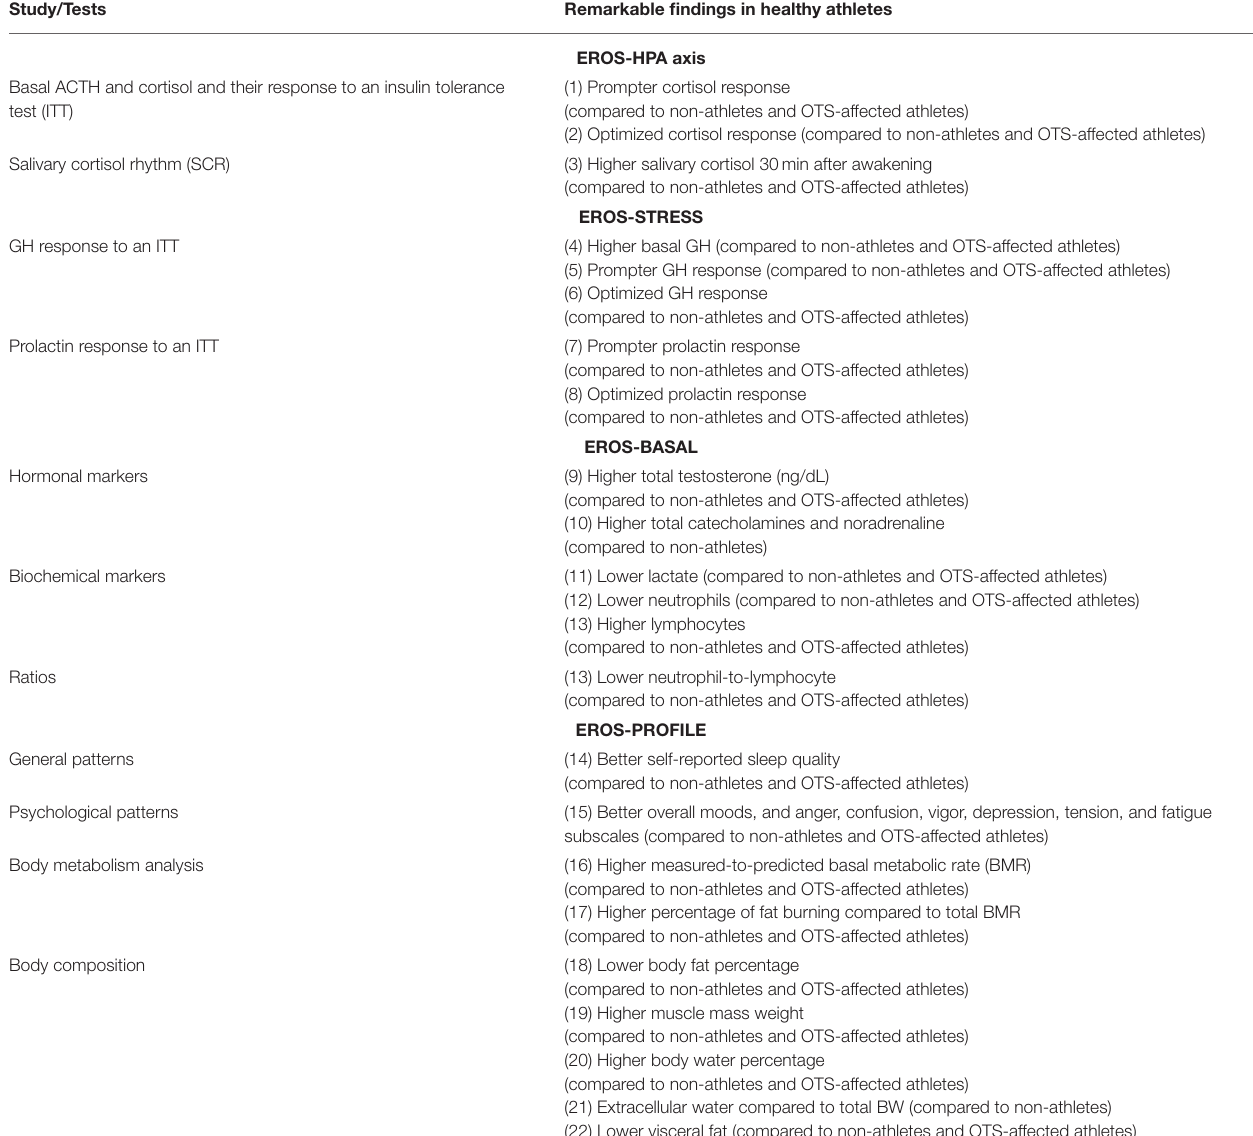
TABLE 6 | Most remarkable findings of the EROS study in healthy athletes.